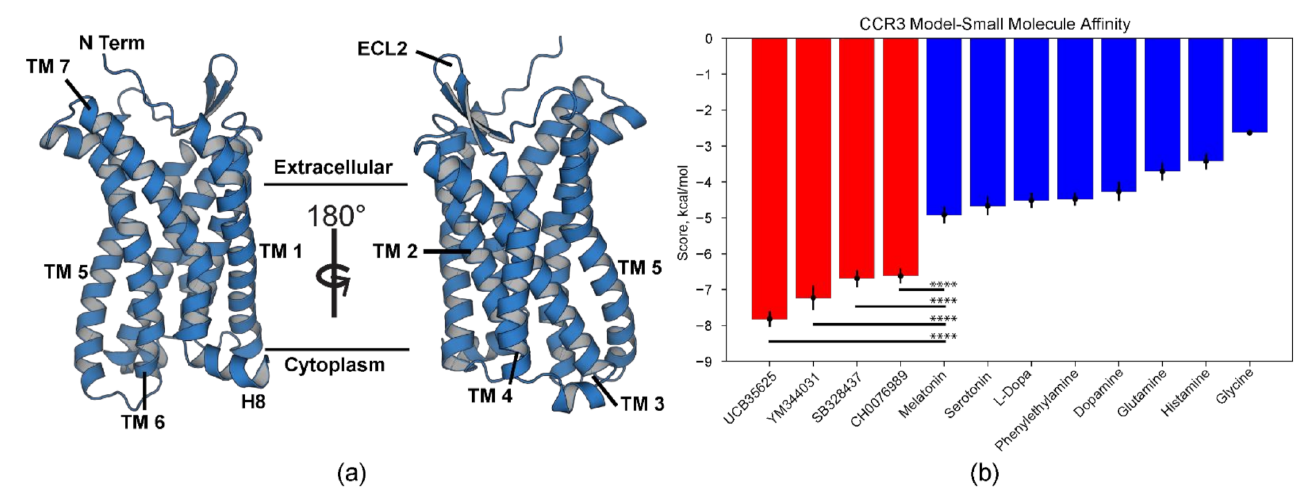
Figure 1. CCR3 final model and docking validation. ( a ) TM1–7, H8, and extracellular loop 2 (ECL2, ligand recognition) are highlighted on the CCR3 homology model. ( b ) Autodock experiments [36,64] between known CCR3-interacting small molecules (red) and several negative controls (blue) suggest high model quality. Data are presented as mean ± Standard Error of the Mean. Bars indicate statistical significance between the two labeled populations based on the Student t -test, where **** denotes p < 0.0001 in the Student t